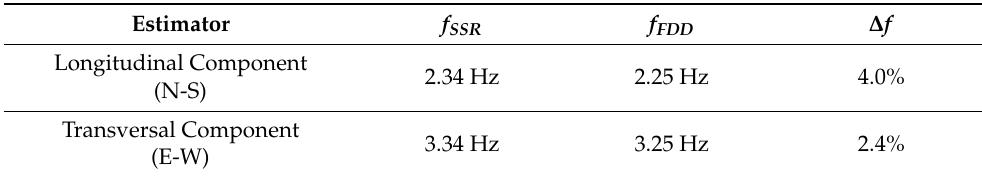
Table 1. Modal frequencies of the façade separated according to longitudinal and transversal components, comparison between SSR and FDD estimations.